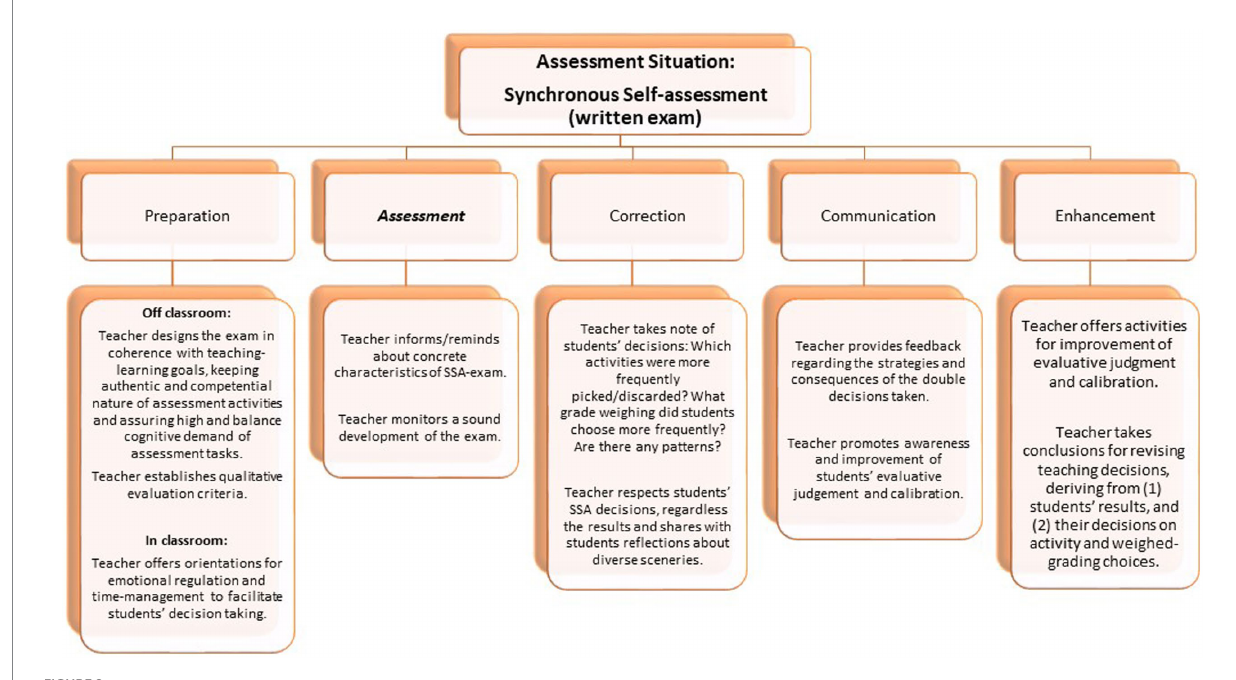
FIGURE 2 Synchronous Self-assessment within the multidimensional model of classroom